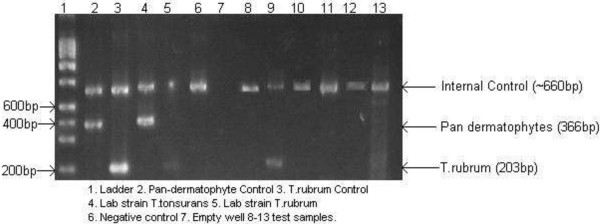
Pan-Dermatophyte PCR test.